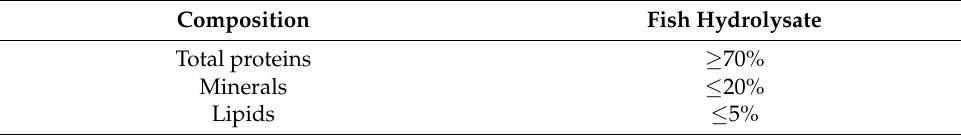
Table 1. Total composition of fish hydrolysate